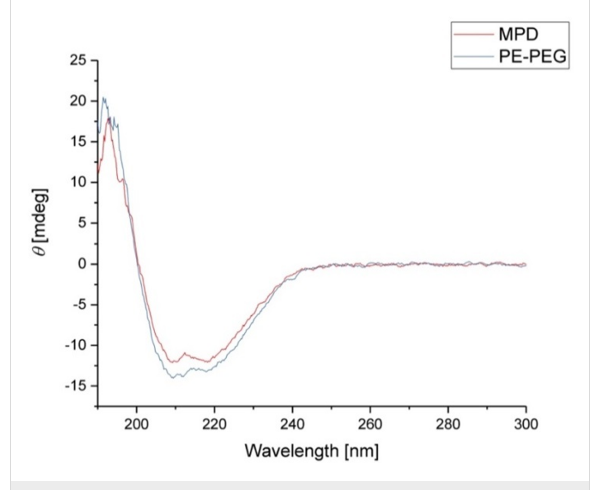
Figure 3: Circular dichroism spectra of 2 refolded in 2-methyl-2,4- pentanediol (MPD, red) and polyethylene–polyethyleneglycol (PE–PEG,